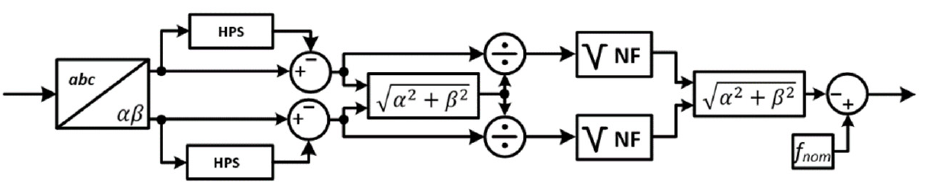
Figure 6. Resonant frequency estimator algorithm, where HPS—high pass filter and NF—notch filter.